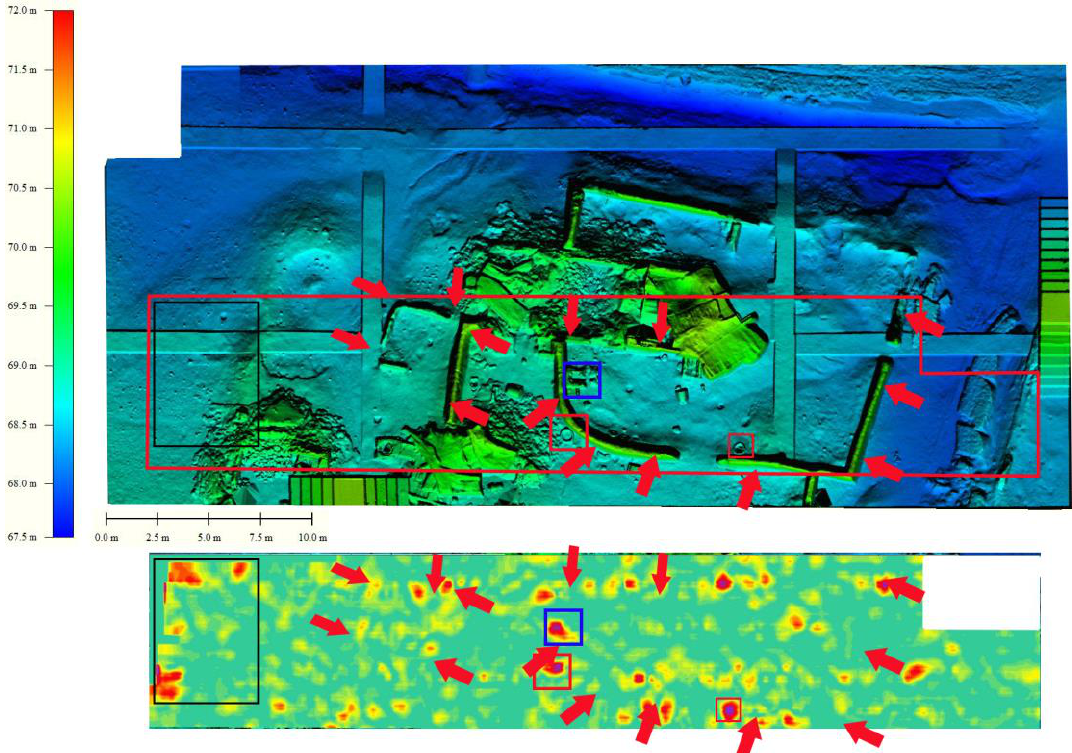
Figure 7. Feed back comparison between archaeological excavated remains and depth slice at 1.25 m related to GPR data acquired using 600 MHz frequency antenna. The red arrows denote the walls that are partially visible from the depth slice. The red quadrangular boxes indicate two iron vessels, the blue box indicates an oven, that are all clearly visible in the GPR depth slice. A number of GPR amplitude anomalies do not refer to any structures and objects but maybe refer to scattered materials due to collapsed structures. Some of them have been removed after the excavation and before the laser scanner survey (see black rectangular box on the left of the investigated area).